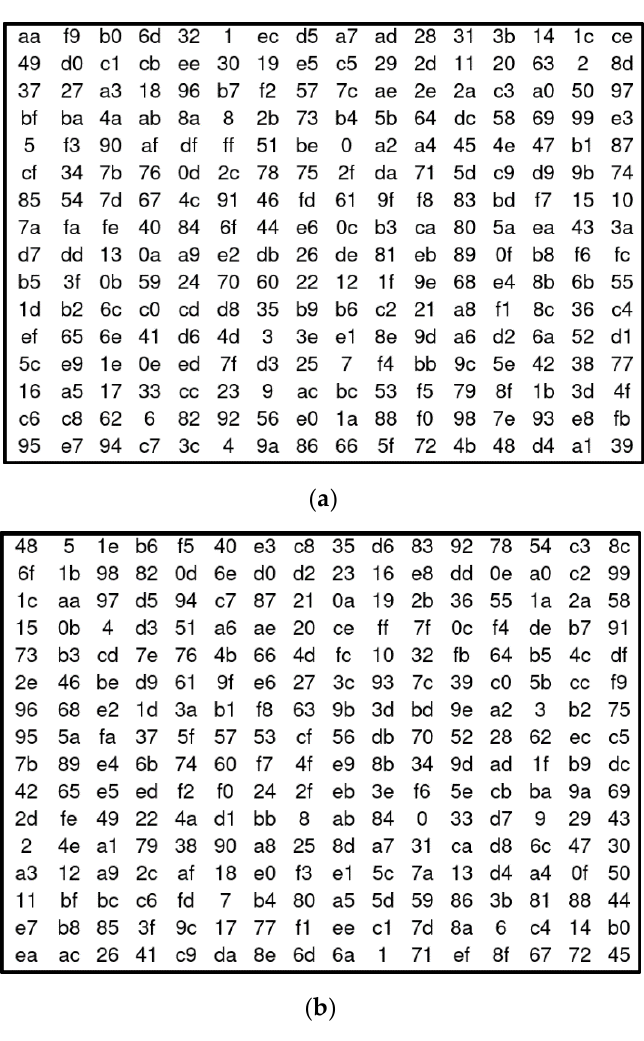
Figure 2. ( a ) Proposed S-Box and ( b ) Inverse of proposed S-Box.